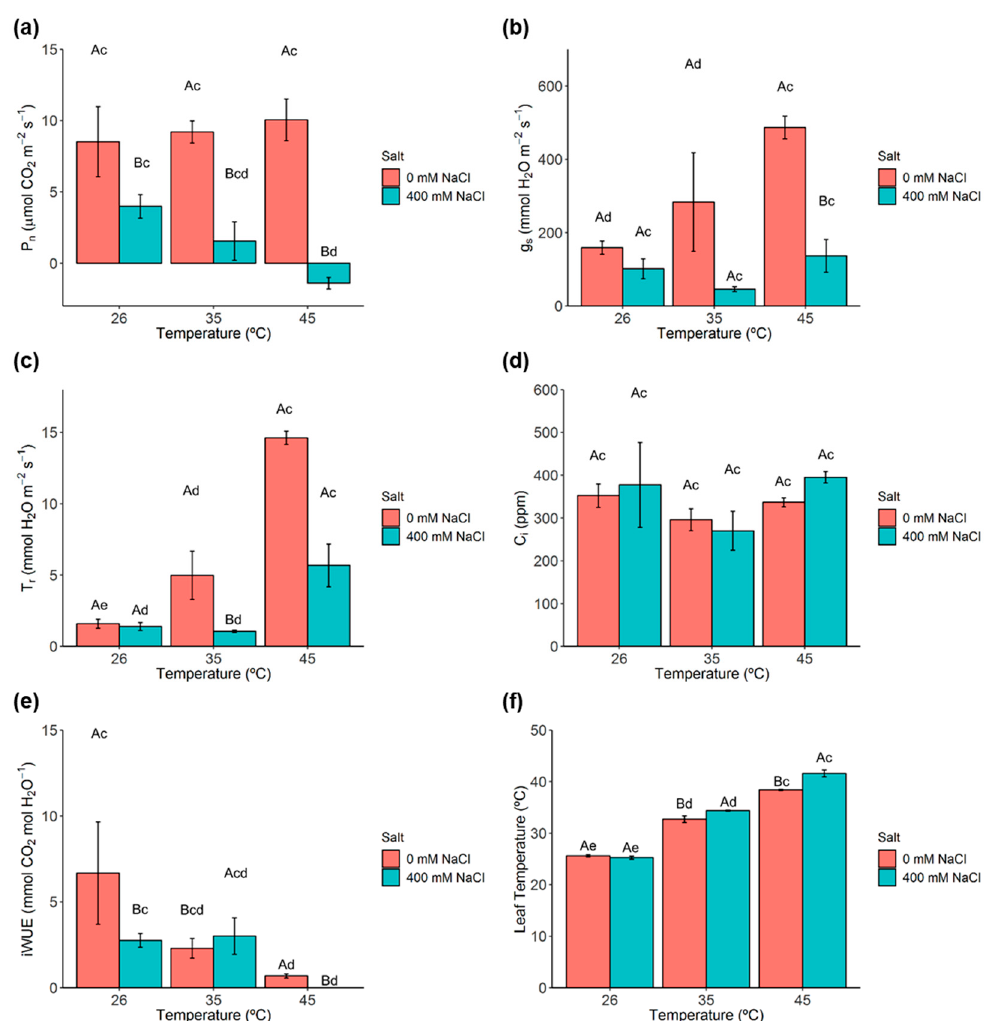
Figure 2. Analysis of gas exchange measurements in C. glauca branchlets under the single and combined exposure to salt (0 and 400 mM NaCl) and temperature (26, 35 and 45 °C) conditions. ( a ) Net photosynthetic rate (P n ). ( b ) Stomatal conductance to water vapour rate (g s ). ( c ) Transpiration rate (Tr). ( d ) Internal CO 2 concentration (C i ). ( e ) Instantaneous water use efficiency (iWUE). ( f ) Leaf temperature. Bars represent the mean values ± SE from three to five independent measurements. Two-way ANOVA ( p < 0.05) followed by Tukey´s HSD test was performed for means comparison and different letters express significant differences between [NaCl] for the same temperature (A, B) or between temperature for the same [NaCl] (c, d, e) with A and c representing the highest values.